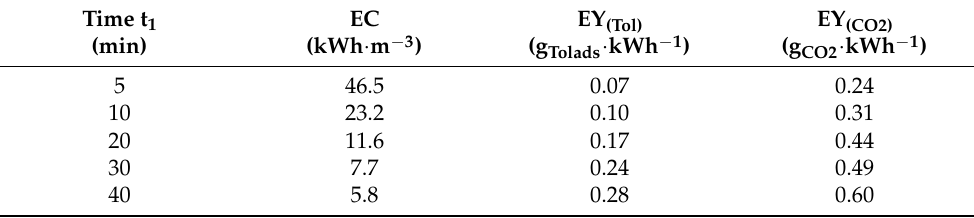
Table 2. Energetic performances of the APC process as a function of storage time span t 1